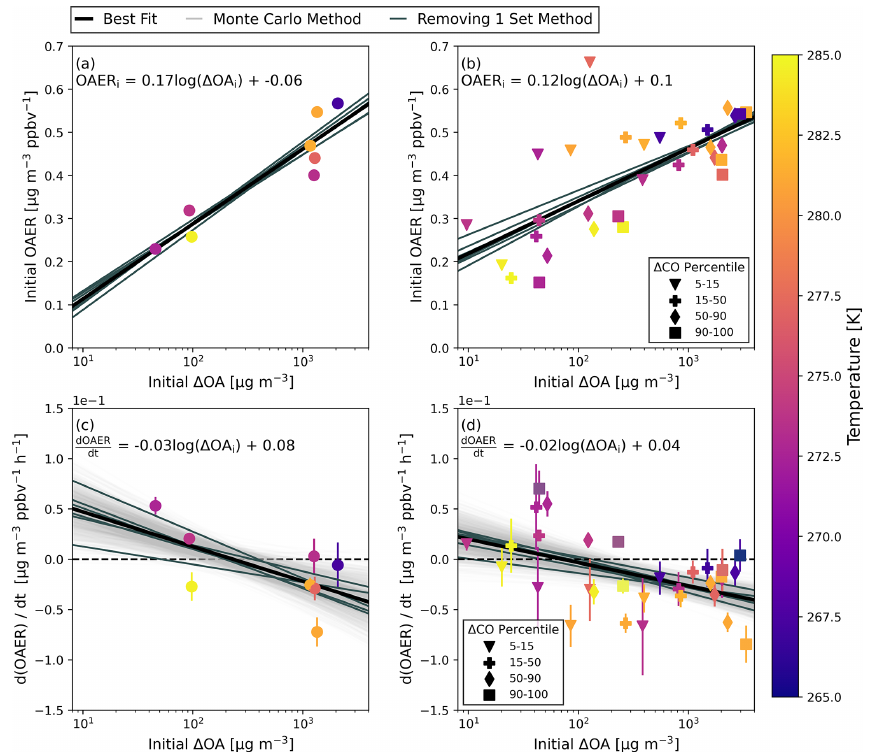
Figure 5. Initial OAER ( (cid:49) OA /(cid:49) CO) versus initial (cid:49) OA for (a) the transect averages and (b) by (cid:49) CO percentile colored by the average in plume temperature at the first transect with an OLS regression line in gray. The statistics for this fit are shown in Table S3. The OAER trends with smoke age based on OLS fitting as a function of (cid:49) OA i for (c) the transect averages and (d) by (cid:49) CO percentile respectively. In each panel, the best-fit line for the points is shown in solid black, with the equation of this line shown in the panel. The darker gray lines are the results of linear regressions with one set of transects removed at a time. In (c) and (d) , 1000 best-fit lines from a Monte Carlo technique are also included in light gray, with statistics for these fits shown in Table S3. The dashed black line in (c) and (d) is the y = 0